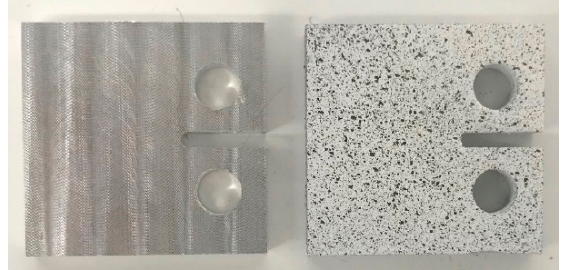
Figure 5. Original specimen ( left ) and speckled specimen ( right ).